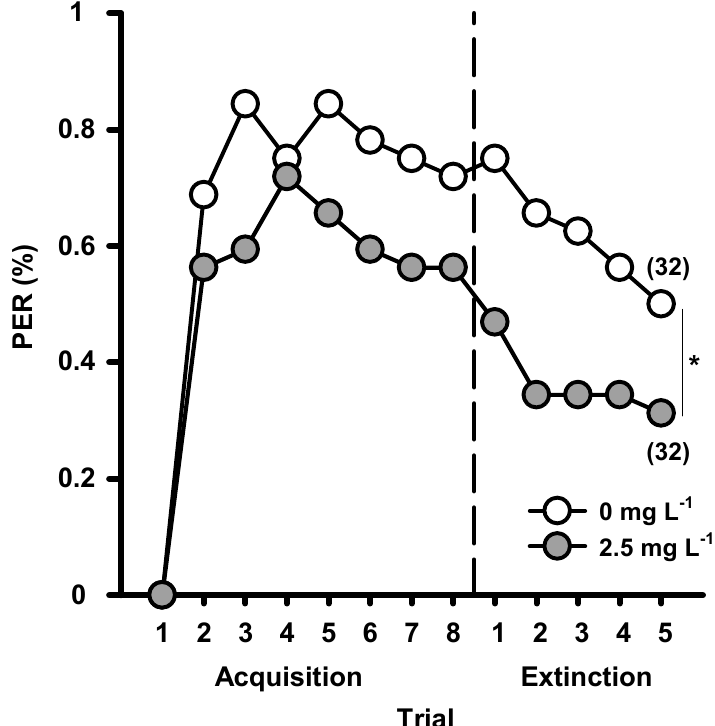
Figure 1. Effect of an acute exposure to GLY on forager honey bee elemental olfactory learning. Percentage of bees captured at the hive entrance that responded to the conditioned stimulus (CS) by extending their proboscis (% PER) in an absolute classical conditioning procedure was quantified over the course of eight acquisition and five extinction trials. During the acquisition phase, bees were offered either sucrose solution alone (control; white) or sucrose solution with 2.5 mg L − 1 GLY (grey), as unconditioned stimulus. The extinction phase, during which the CS was not rewarded, started after the acquisition phase. Numbers in brackets indicate the number of bees in each treatment. Mann–Whitney: * p < 0.05. Reproduced with permission from Herbert and co-workers, Journal of Experimental Biology; published by The Company of Biologists, 2014.